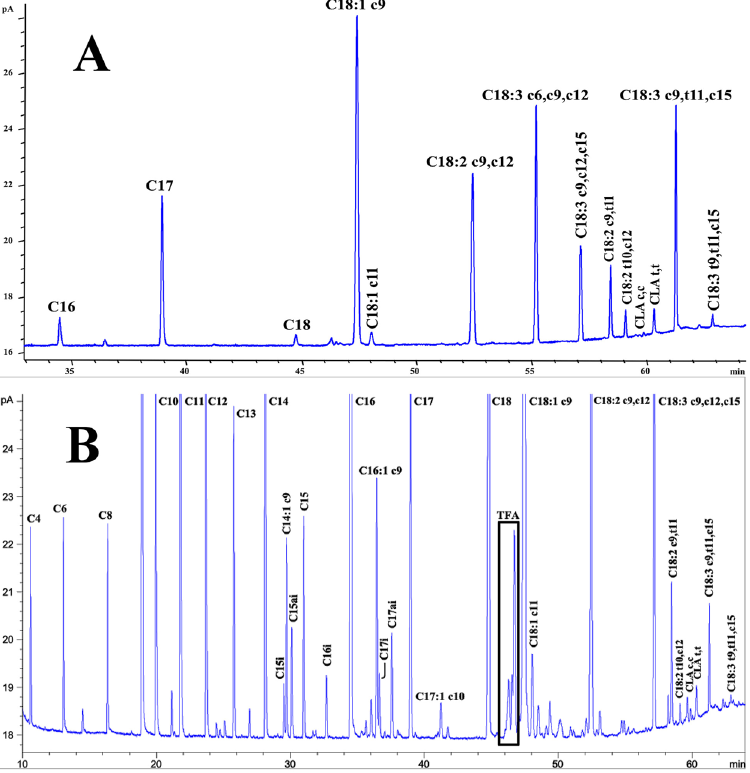
Figure 4. Fatty acid composition of cys-MRS culture medium ( A ) and commercial semi-skimmed UHT milk ( B ) assayed for conjugated fatty acid production by B. breve NCIMB 702258 using linoleic (LA) and linolenic ( α -LNA) acids as precursor substrates. A mixture of LA/ α -LNA/ γ -LNA in cys-MRS culture medium and LA/ α - LNA in semi-skimmed UHT milk were assayed at a concentration of 0.5 mL/mg for each fatty